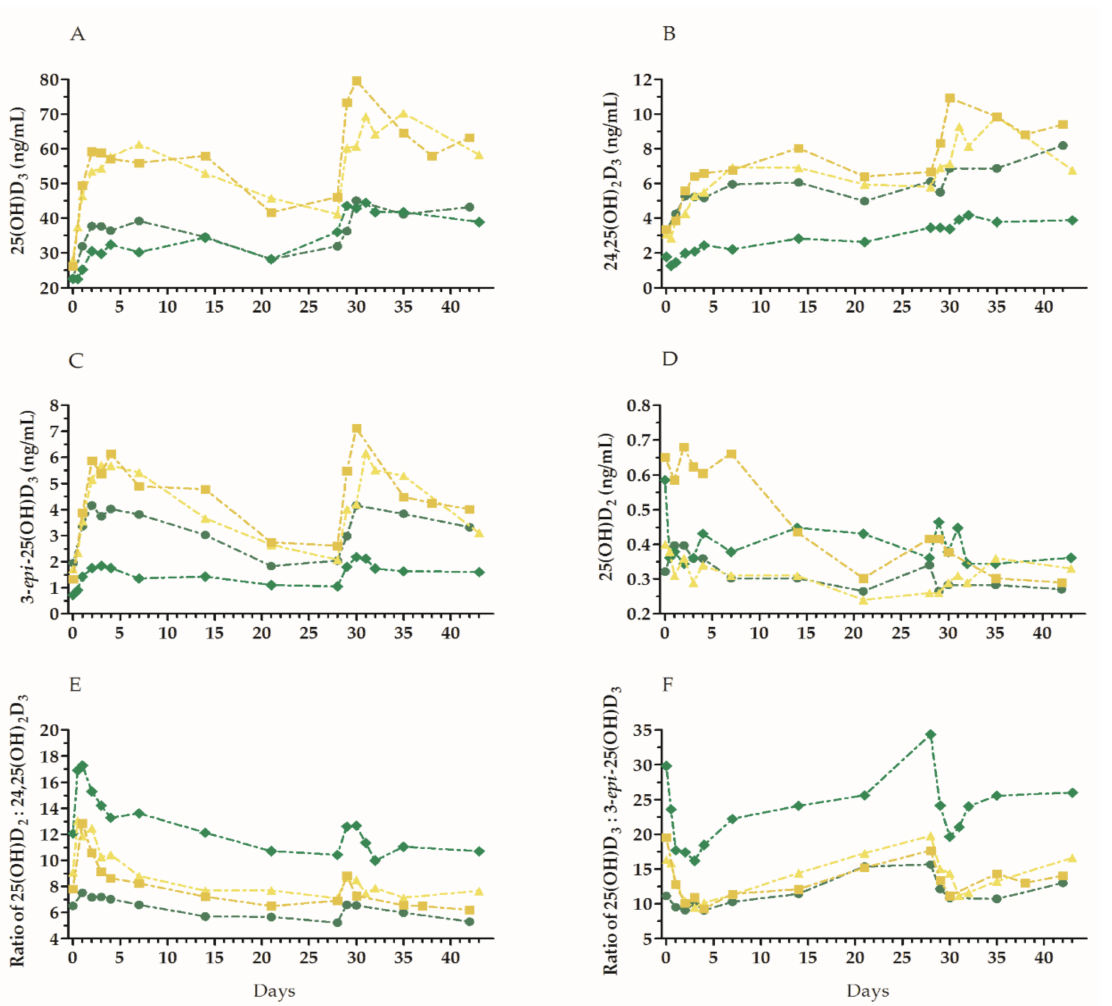
Figure 2. Changes in vitamin D metabolite levels in the serum, and metabolite ratios over time, in four healthy volunteers after receiving two doses of vitamin D 3 . The doses were given on days 0 and 28. Notation: green lines and symbols—participants administered with 100,000 IU; yellow lines and symbols—participants administered with 200,000 IU. The following were determined: 25(OH)D 3 levels ( A ); 24,25(OH) 2 D 3 levels ( B ); f25(OH)D 3 levels ( C ); 25(OH)D 2 ( D ); ratio of 25(OH)D 3 to 24,25(OH) 2 D 3 ( E ); ratio of 25(OH)D 3 to 3- epi -25(OH)D 3 ( F